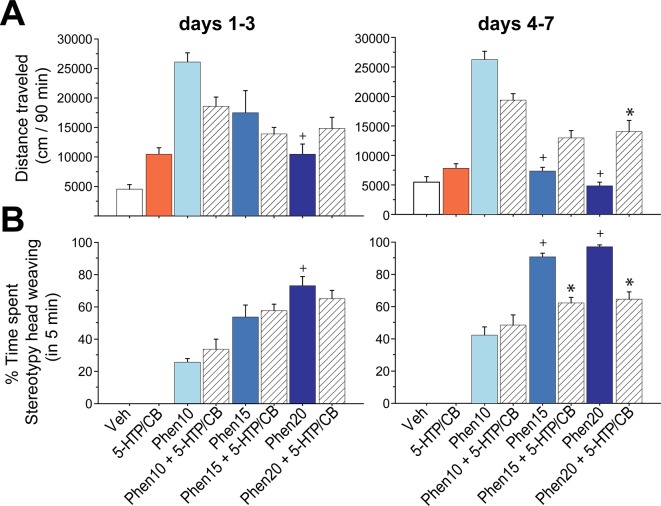
The triple drug combination partially reverses psychomotor side effects (locomotion and stereotypy) of Phen. (A)
Left panel: the total distance traveled (cm/90 min), forward locomotion, across the first three days (days 1–3), and last four days (days 4–7, right panel) after injection of vehicle or treatment. Same conventions as in
Figure 2
. (B)
Left panel: cumulative duration, in percentage, of stereotypy during 5 min measured after 1 h from onset of injection for days 1–3 and days 4–7 blocks (right panel). Data are mean ± sem. +
p 0.05 relative to Phen10, *p 0.05 indicates values significantly different from its corresponding Phen dose used in the combination.